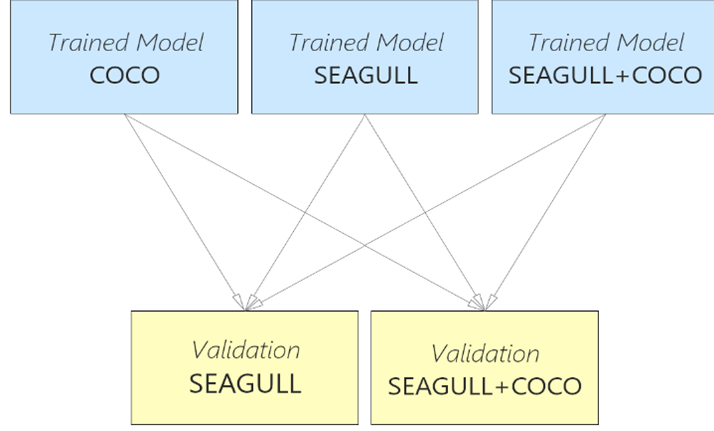
Figure 6. Tested combinations between algorithms and datasets.